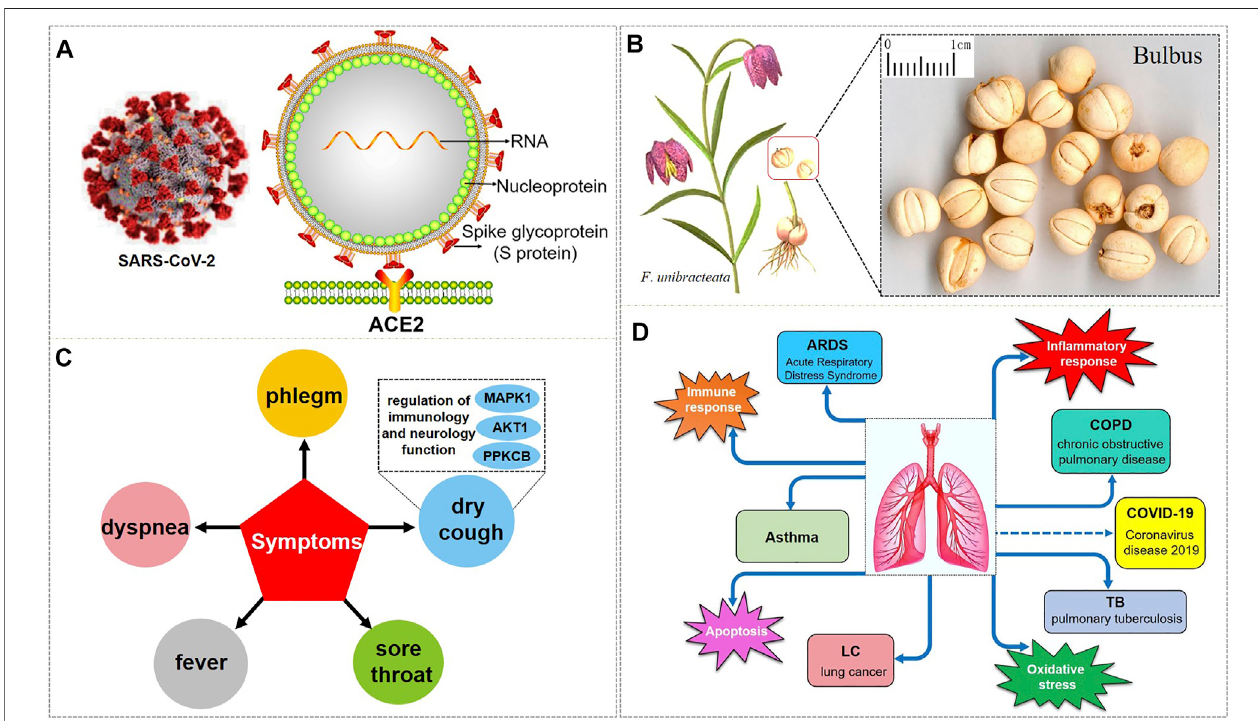
FIGURE 1 | SARS-CoV-2 and the respiratory diseases, biological processes, and symptoms that BFC have an effect on. (A) is the 3D and 2D structure of SARS- CoV-2 with its composition. (B) is F. unibracteata , one of the plant sources of BFC with its bulbus. (C) is the symptoms that BFC can relieve. (D) is the respiratory diseases and correlative biological processes that can be intervened by